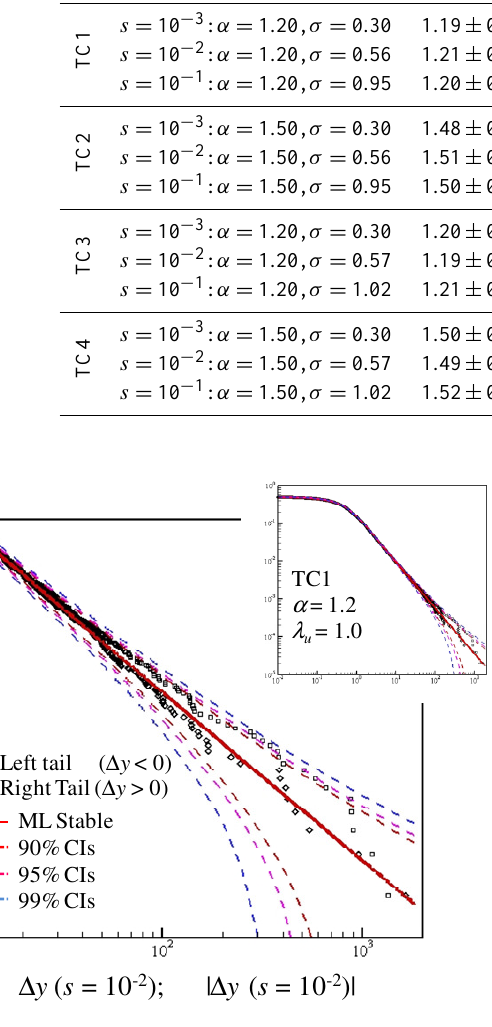
at s = 10 − 2 , in Fig. 7a, identifies the first two ( k = 1 and 2) highest ranking outliers as DKs; so did the confidence inter- val test (Table 2 and Fig. 3). A similar plot for the left tail at s = 10 − 1 , in Fig. 7b, diagnoses the outlier at k = 1 as a DK; the same applies for the confidence interval test (Table 2). Plots of p versus k for the left tail associated with TC4 at s = 10 − 2 and s = 10 − 1 , respectively, in Fig. 8a and b, iden- tify the first three ( k = 1 − 3) and first ( k = 1) highest ranking outliers as DKs, in accord with the confidence interval